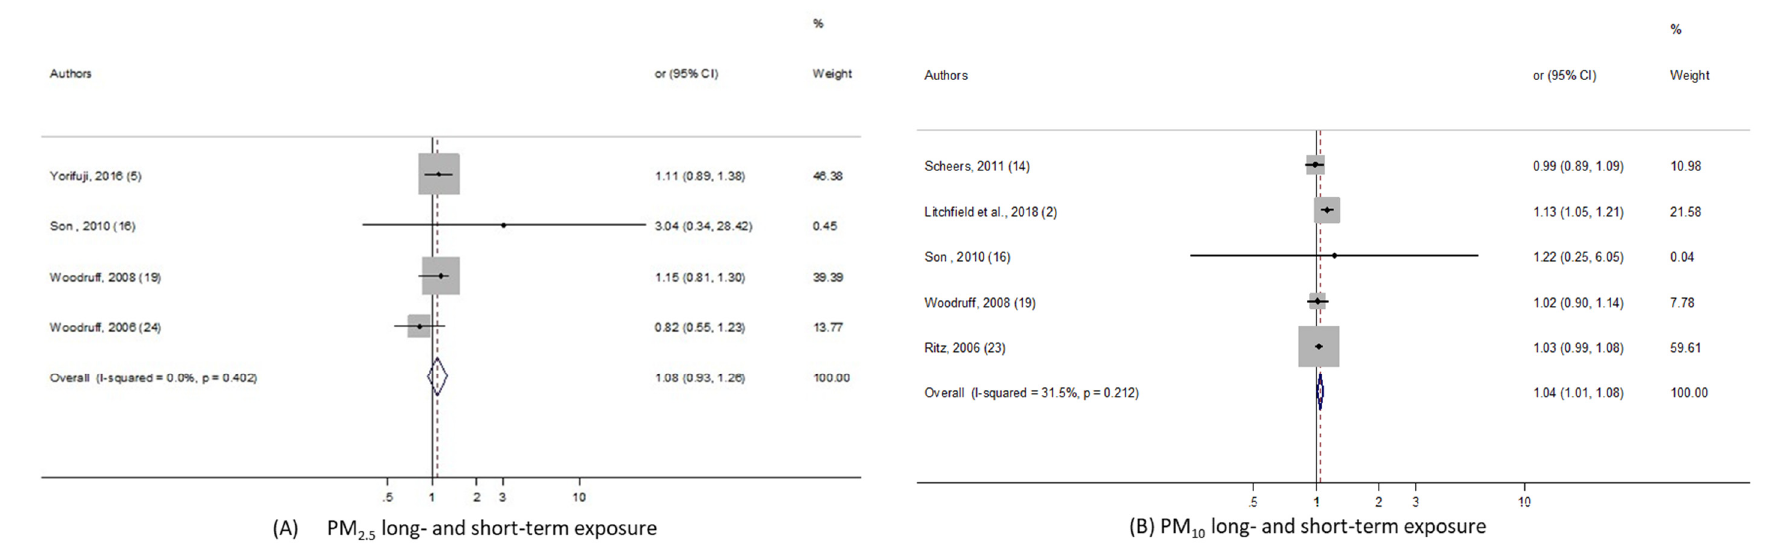
Figure 4. Forest plots for combinations of sudden infant death syndrome and pollutant. The size of each square represents the weight that contributes to the combined e ff ect, respectively for: ( A ) Long- and short-term PM 2.5 ; ( B ) long- and short-term PM 10